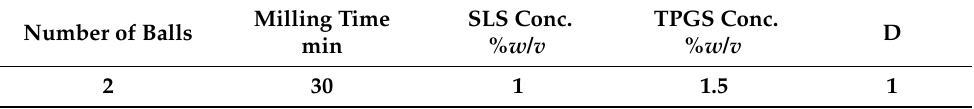
Table 2. Summary of optimisation parameters and predicted outputs. Number of